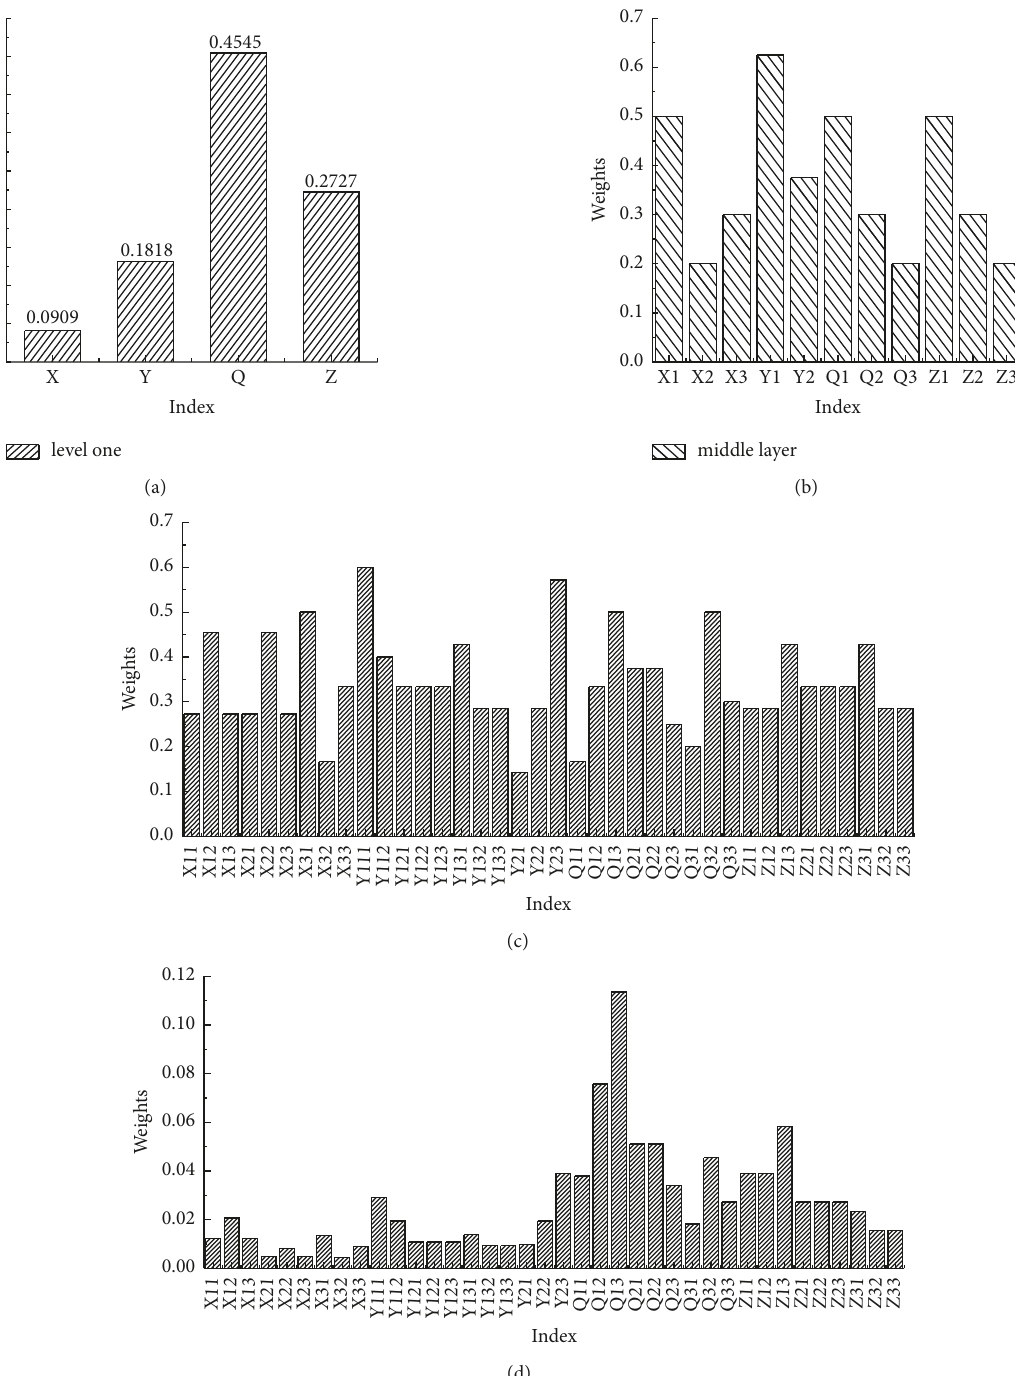
Figure 7: Weights of performance evaluation level indicators. (a) First layers. (b) Middle layers. (c) Target layer. (d) Comprehensive